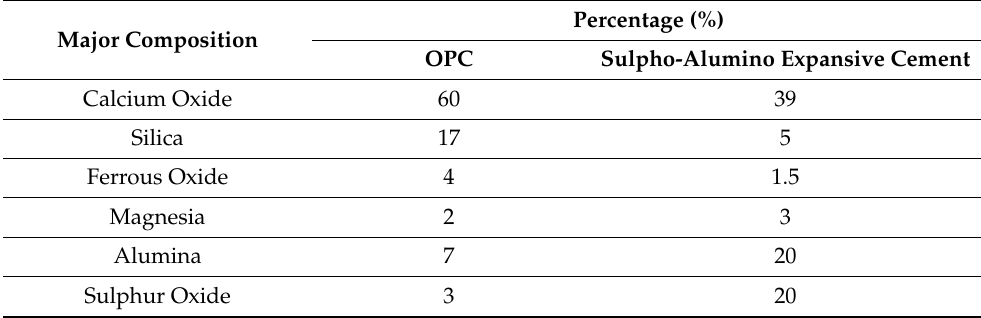
Table 1. Chemical composition of OPC and sulpho-alumino expansive cement [2]. Major Composition